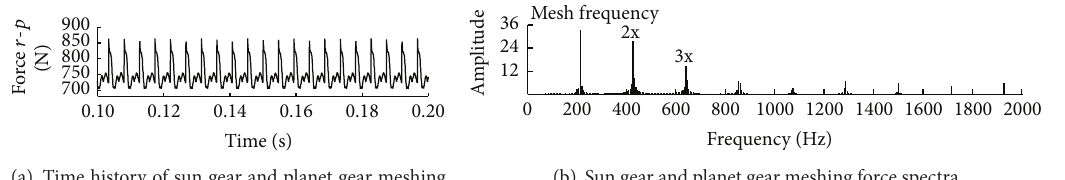
Figure 6: The dynamic force of ring gear and planet